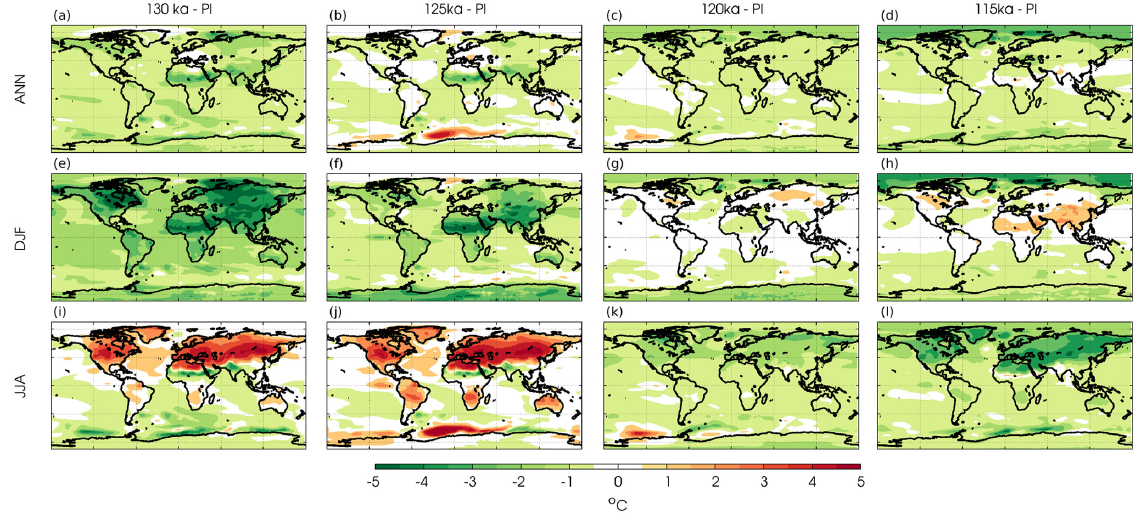
Figure 8. Simulated changes of near-surface air temperature for the Eemian experiments relative to the pre-industrial experiment (PI). Panels (a) – (d) show the annual mean, and panels (e) – (h) and (i) – (l) show the DJF and JJA mean, respectively. The columns show the temperature changes for the 130, 125, 120, and 115ka experiments from left to right. Model results are annual means over the last 100 years of model integration. A latitude/longitude grid is indicated with dashed lines with a 60 ◦